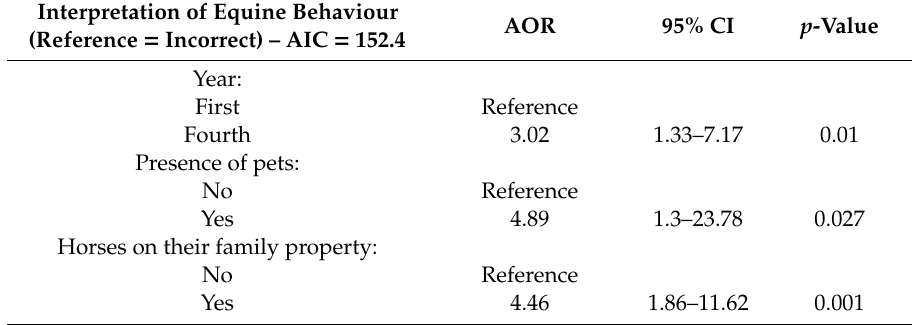
Table 6. Best-fitted binomial logistic regression model outcomes and adjusted odds-ratios (AOR), with interpretation of equine behaviour as dependant variable, using Akaike Information Criterion